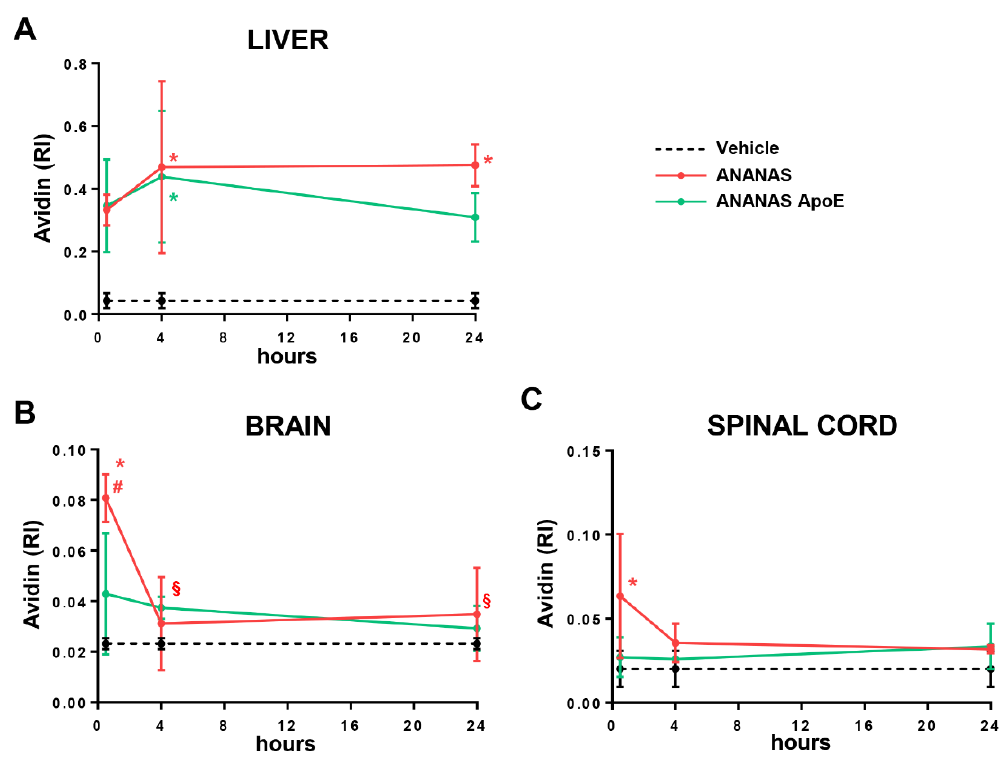
Figure 4. NP biodistribution in SOD1 G93A mice. ( A – C ) Dot blot analysis for avidin quantification in the liver ( A ), brain ( B ), and spinal cord ( C ) of SOD1 G93A mice treated with a vehicle (dotted line), ANANAS (red line), and ANANAS-ApoE (green line) and sacrificed with intracardial perfusion 30 min, 4 h, and 24 h after the injection. ( A – C ) Data are mean ± SD ( n = three or four in each experimental group) and indicates the relative immunoreactivity (RI) normalized to total protein loading; * p < 0.05 versus vehicle; # p < 0.05 versus ANANAS-ApoE and § p < 0.05 versus 30 min, by one-way ANOVA, Tukey’s post hoc test.